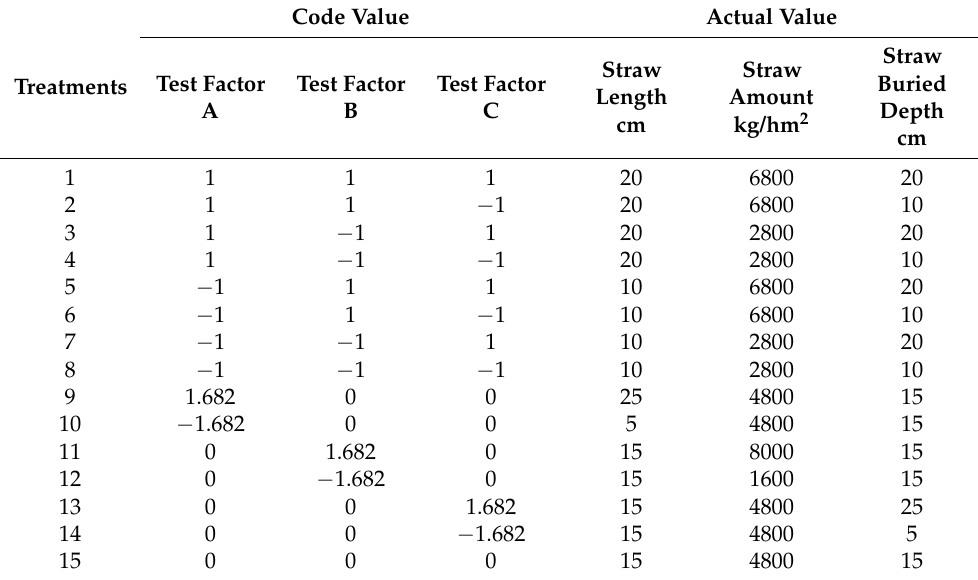
Table 1. Test design.